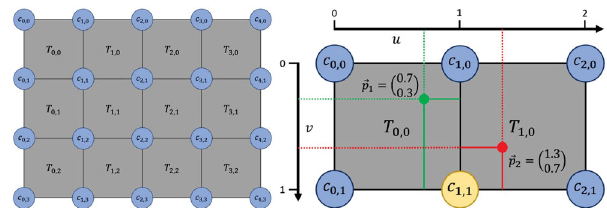
Left: different texture variations T u,v side by side with shared corners C i,j . Right: texture patches are addressed using U – V mapping. Different variations are accessible by using multiples of the default range [0 , 1].